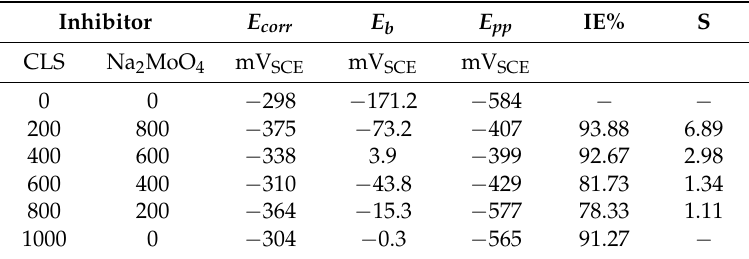
Table 1. Electrochemical parameters of Q235 steel in carbonated SCP solution with different ratios of CLS and Na 2 MoO 4 using cyclic potentiodynamic polarization (CPP)